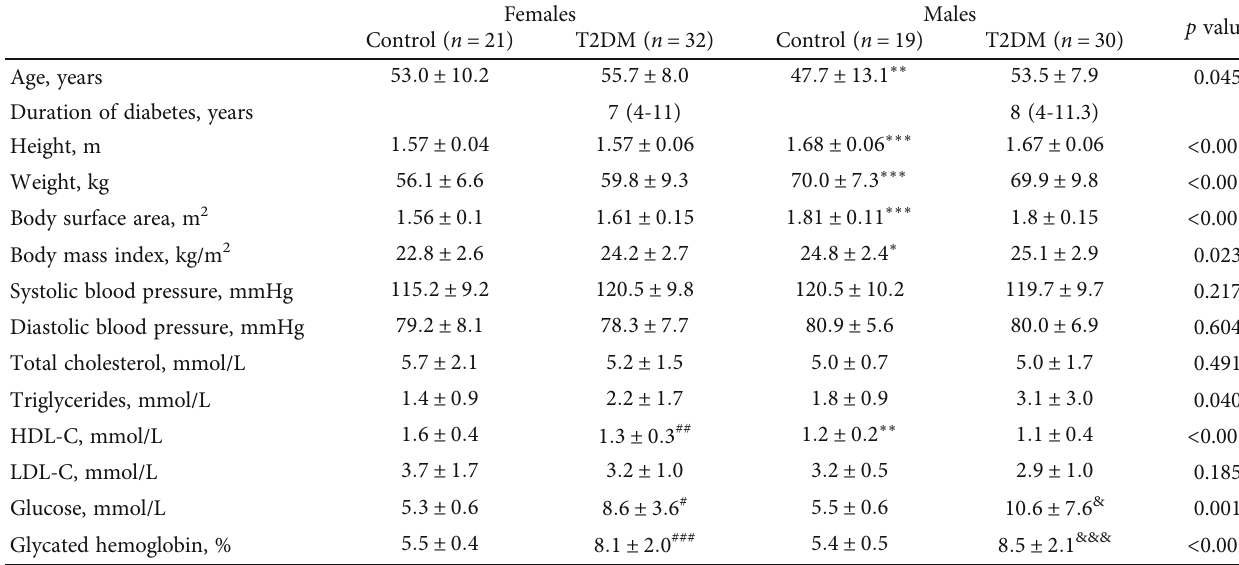
Table 1: Demographic and biochemical data of all